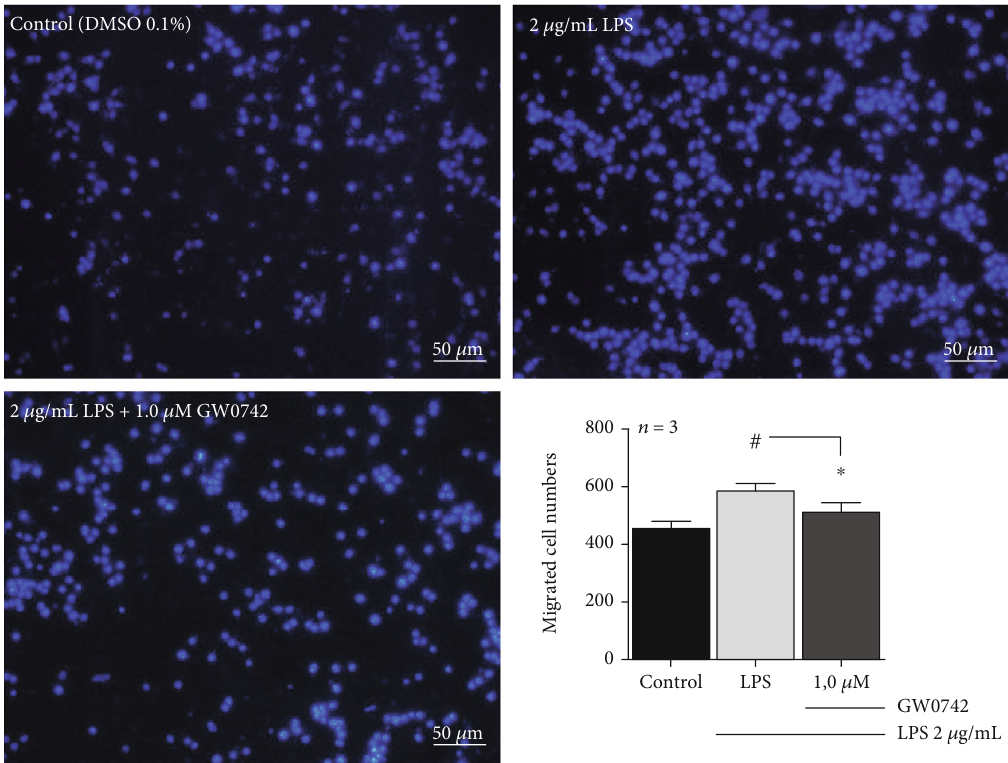
Figure 4: Pretreatment with GW0742 downregulates LPS-stimulated hDPCs ’ chemotactic ability: LPS-stimulated hDPCs recruited more RAW264.7 macrophage cells when compared with control cells. Pretreatment of LPS-stimulated hDPCs with 1.0 μ M GW0742 signi fi cantly reduced the number of migrated macrophage cells ( p < 0 : 05 ; # vs. control; ∗ vs. LPS by one-way ANOVA and post hoc Newman − Keuls; mean ± S : E : M : n = per group